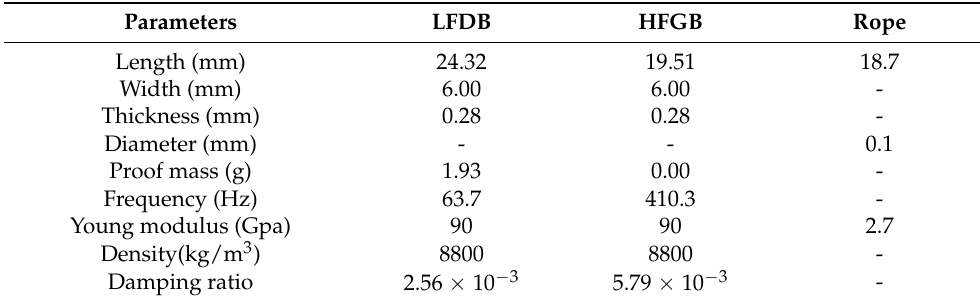
Figure 4. ( a ) Device fabrication and ( b ) detailed experimental setup of the PVEH system. Table 3. Simulation and experiment parameters of LFDB, HFGB and the